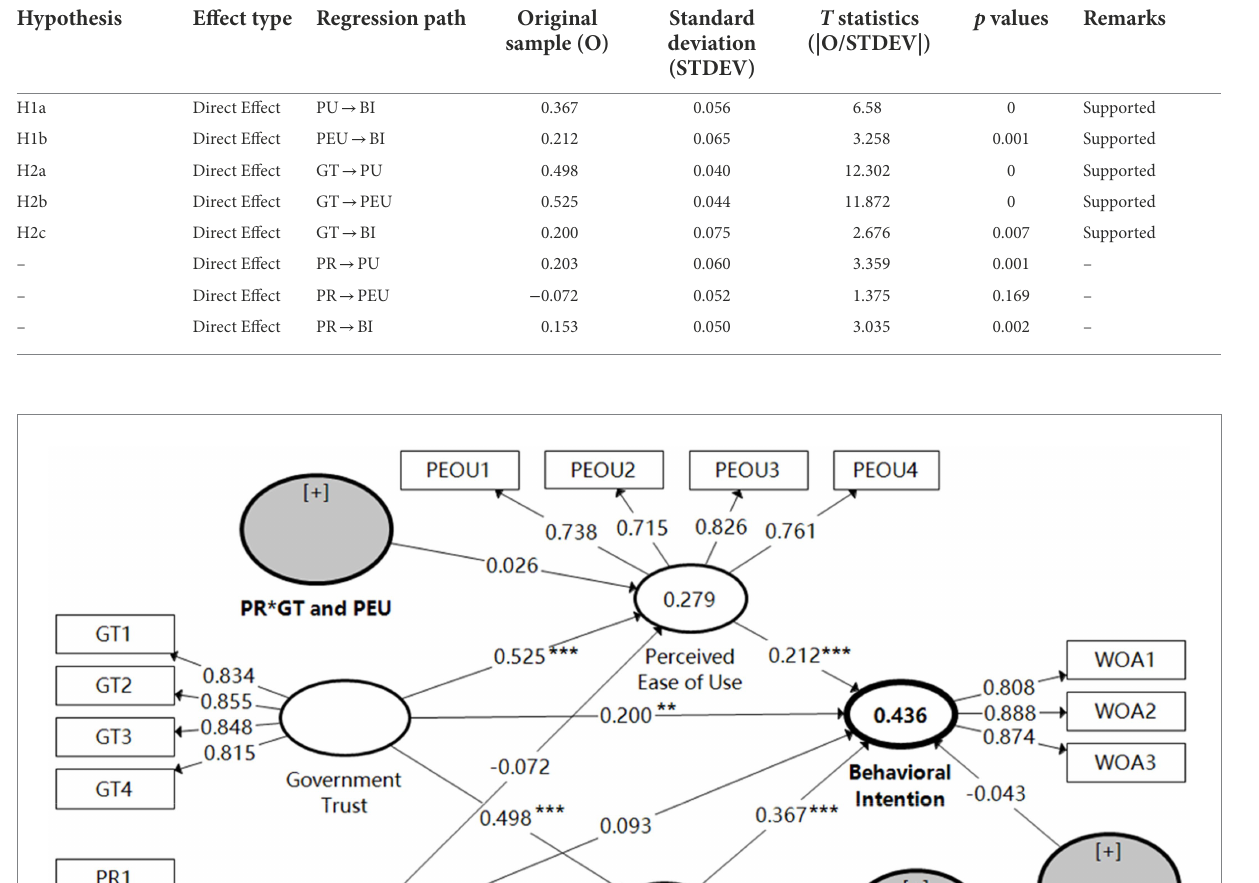
TABLE 6 Hypothesis testing and strength of the model.